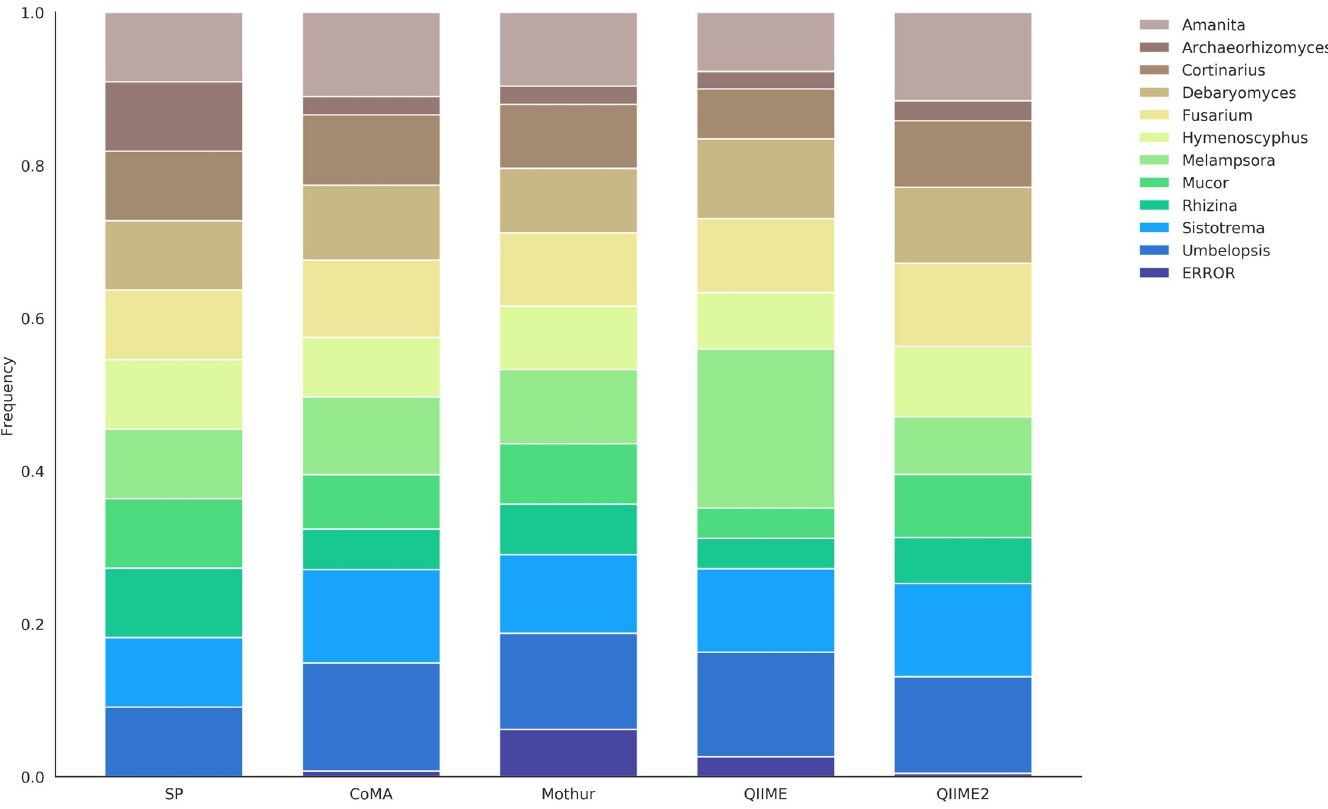
Fig 4. Community composition of the mock-26 dataset, revealed with four different analysis platforms. The set point (SP) depicts the theoretically expected distribution and serves as reference. The dataset comprised 11 fungal genera, targeted with ITS amplicon sequencing.